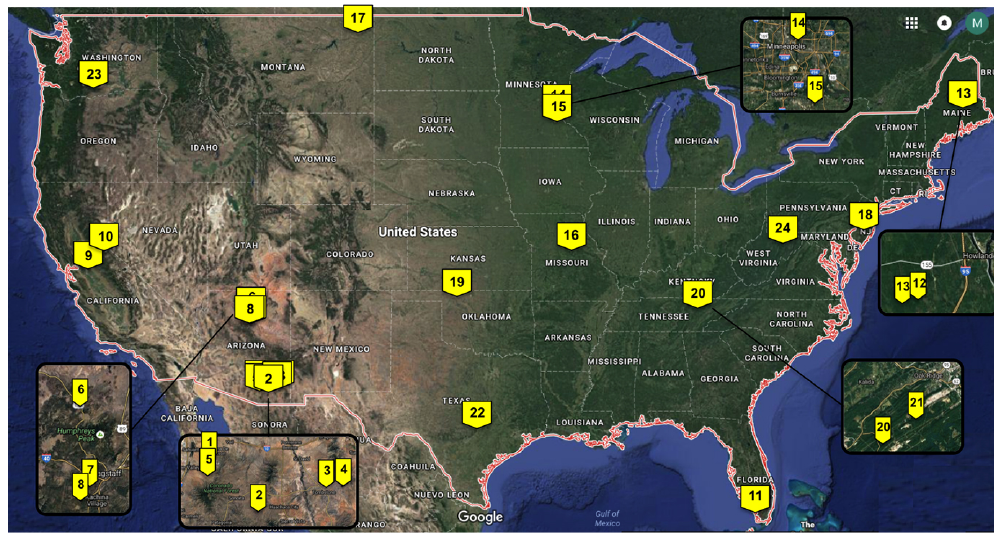
Figure 2. Test site locations in the USA.